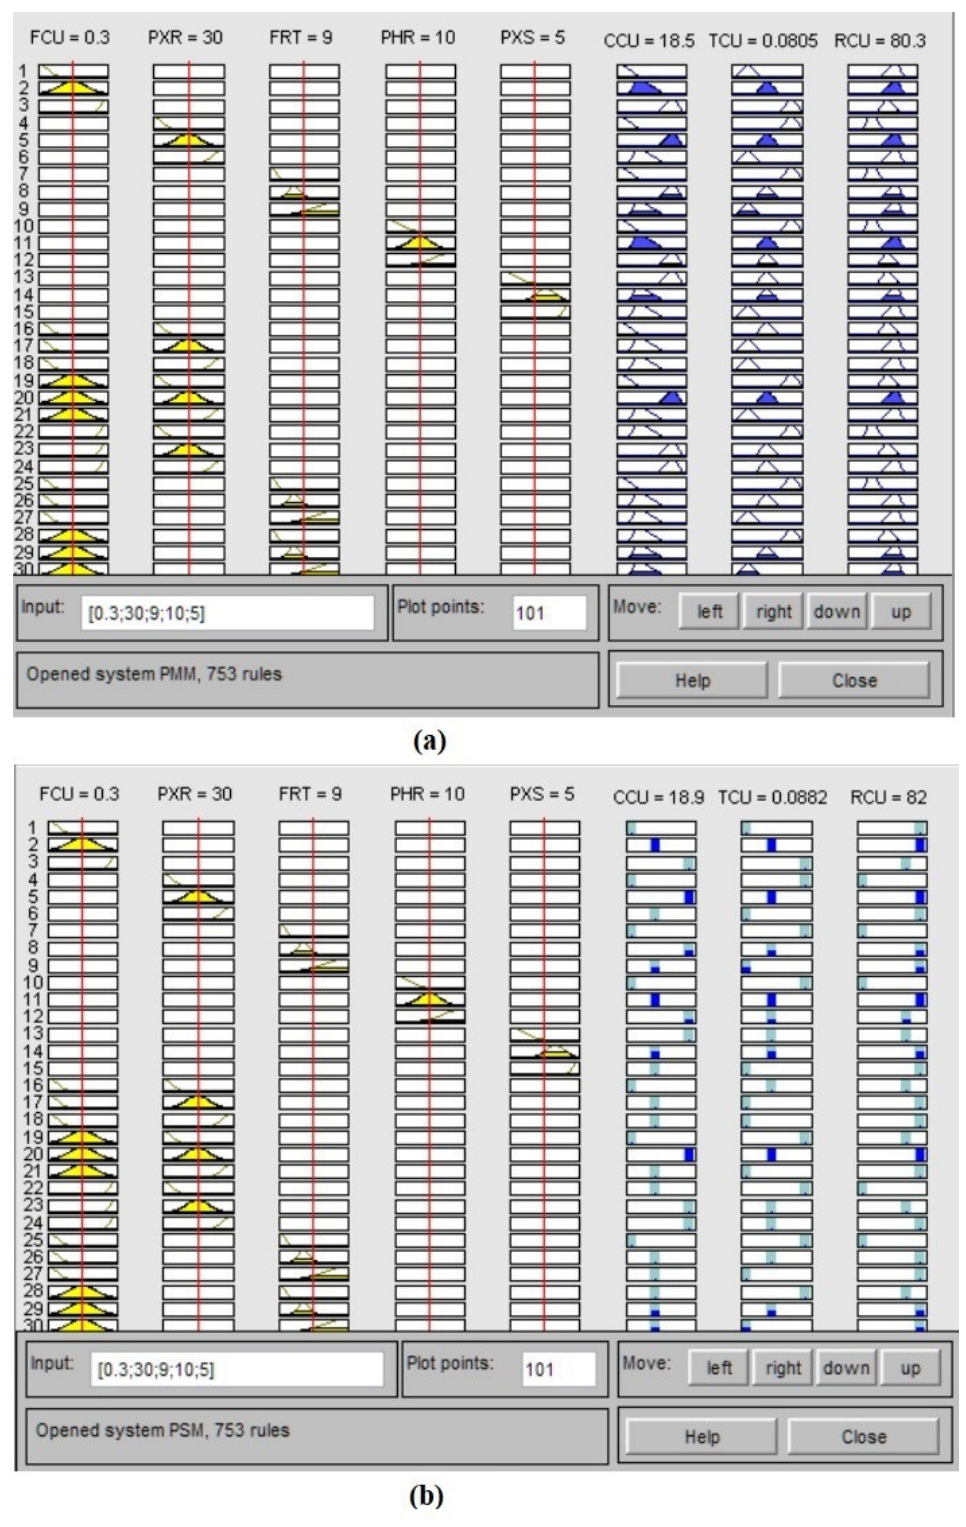
Figure 6. Display of the detail of the rule base: ( a ) PMM and ( b ) PSM model.